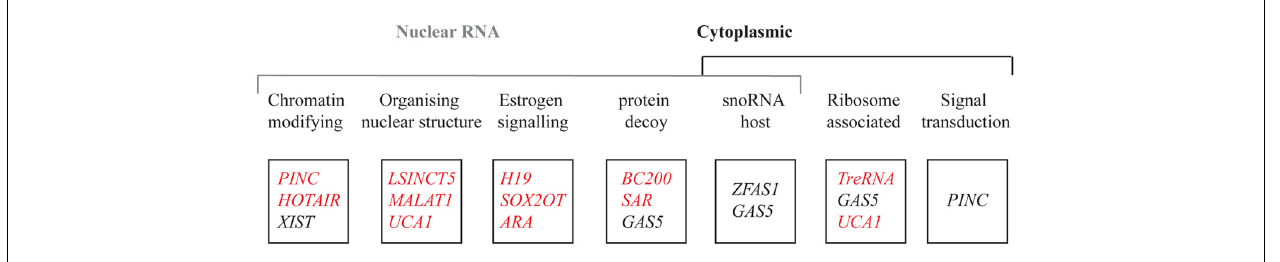
FIGURE 3 | List of lncRNAs reported in this review based on their localization, function, and expression pattern. The function of each lncRNA is above each box.The red and black represent the genes upregulated and downregulated respectively in breast cancer.